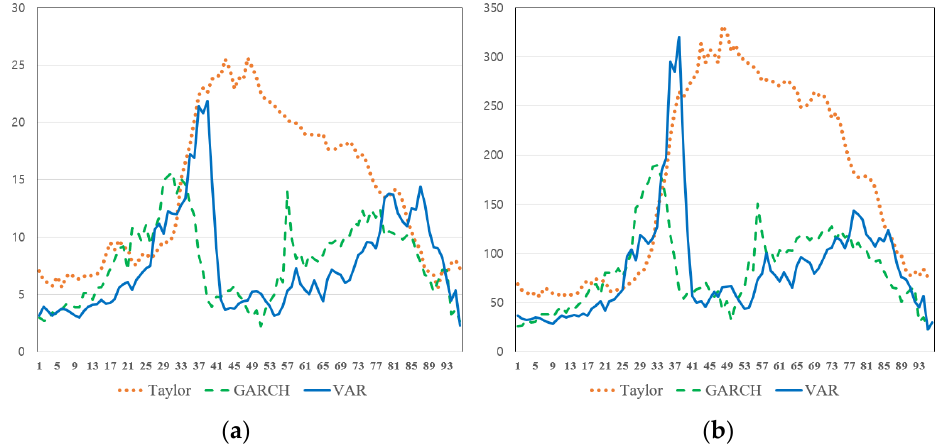
Figure 6. Forecast (k = 8) performance evaluations categorized by quarter-hour for models in terms of ( a ) MAPE and ( b ) RMSE. of ( a ) MAPE and ( b )